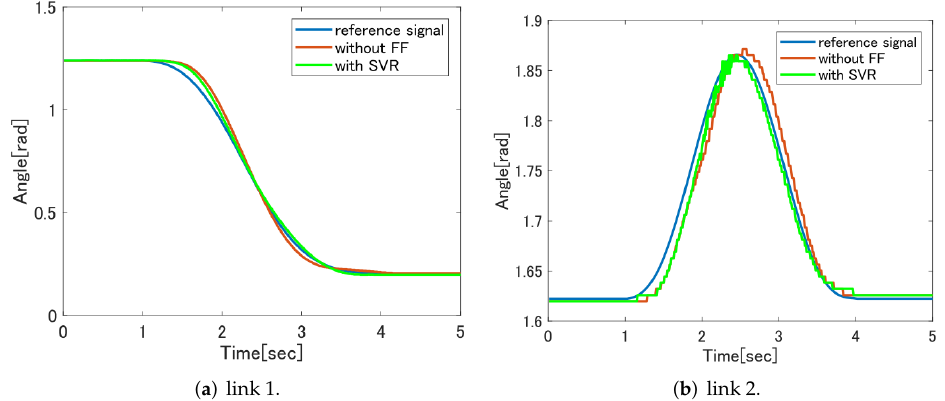
Figure 12. Comparison of FF without controller and SVR FF with controller.